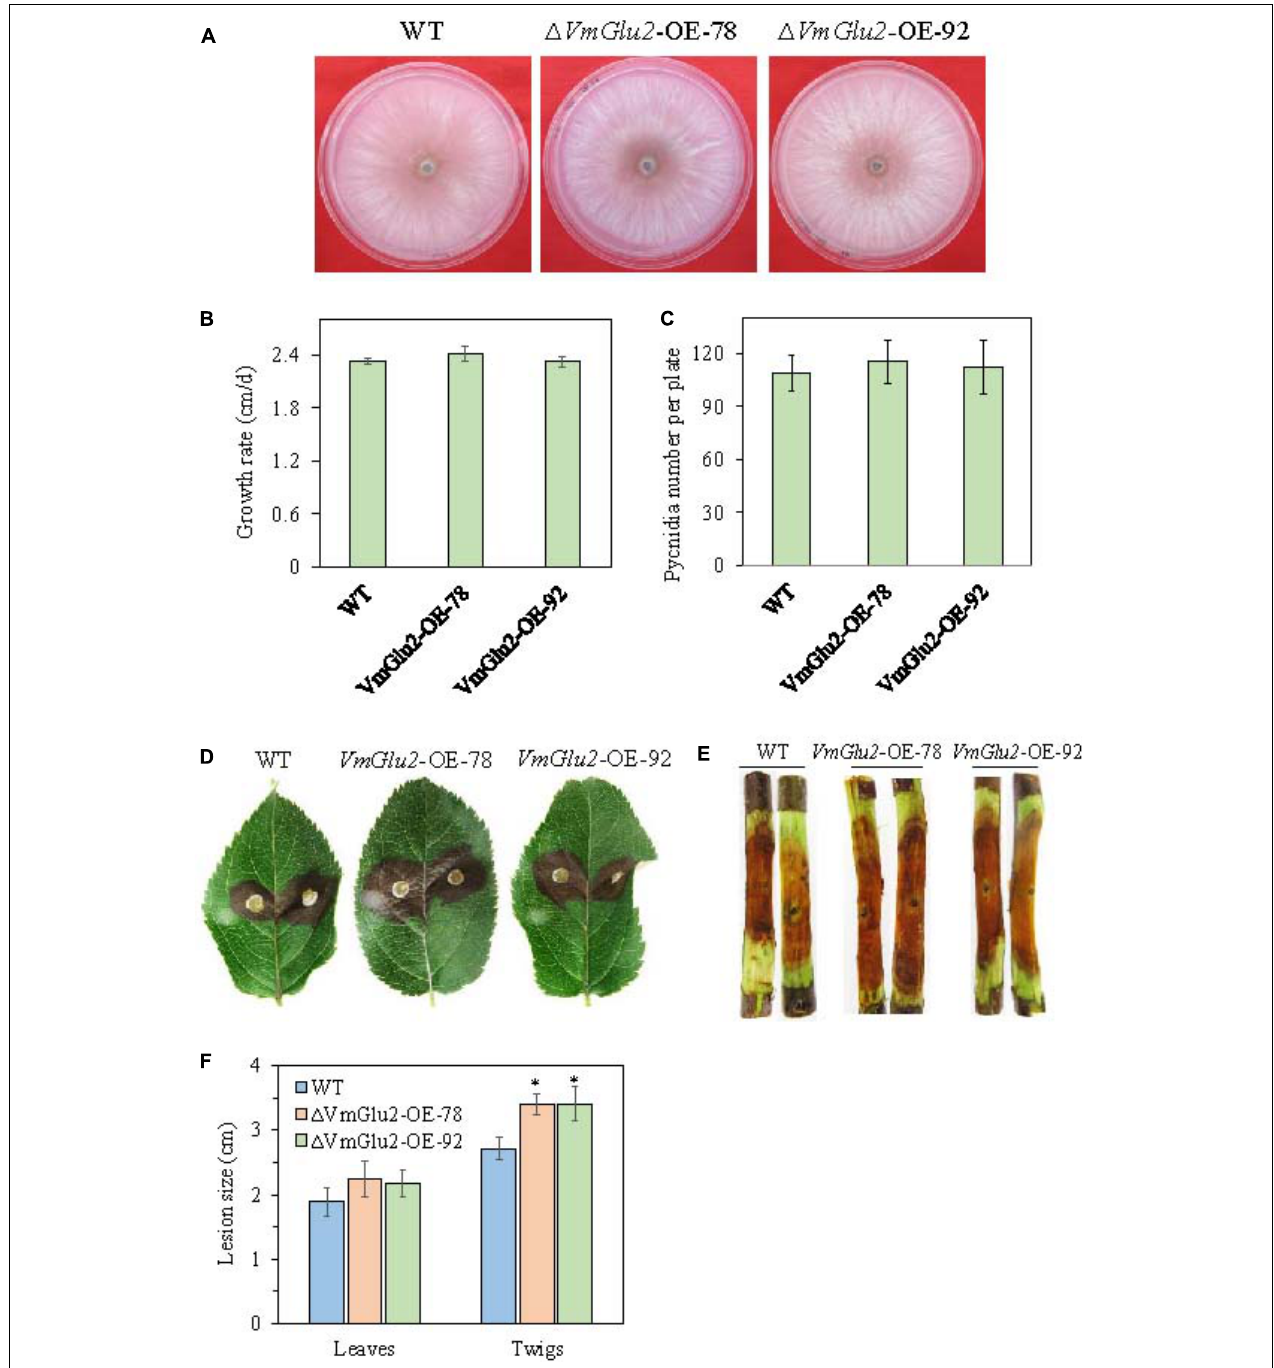
FIGURE 7 | Overexpression of VmGlu2 does not affect the growth and development of V. mali , but increases the virulence of V. mali in the leaves and twigs of M. domestica Borkh. cv. Fuji. (A) Colony morphology of WT and VmGlu2 overexpression (OE) transformants for 4 days incubation on PDA. (B) Growth rate of WT and VmGlu2 overexpression transformants on PDA for 3 days. (C) Number of pycnidia produced in the 9.0 cm per petri plate. Bars indicate standard deviation of means of four replicates. (D) Pathogenicity assay of the WT and VmGlu2 overexpression (OE) transformants on apple leaves at 3 dpi. (E) Pathogenicity assay of WT and VmGlu2 overexpression transformants on the apple twigs at 5 dpi. (F) Lesion sizes produced by different strains on the apple leaves at 3 dpi and apple twigs at 5 dpi. The mean lesion length was calculated from 6 apple leaves and 10 apple twigs. Bars represent the standard deviation. Asterisks indicate significant differences in OE transformants as compared to that in the WT ( P <